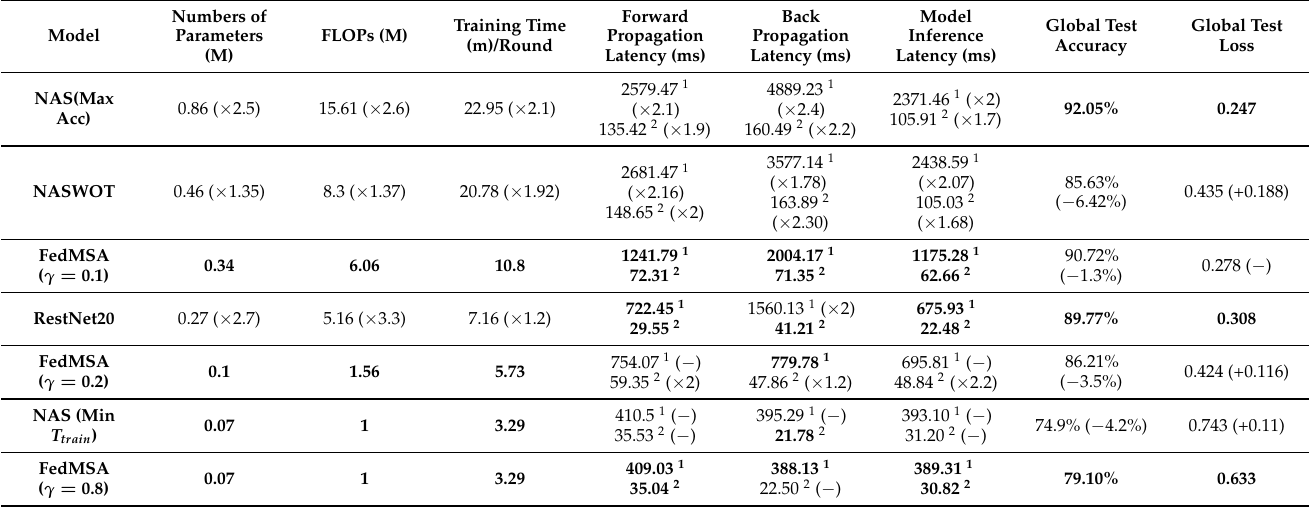
Table 1. Result Summary Total Communication Round